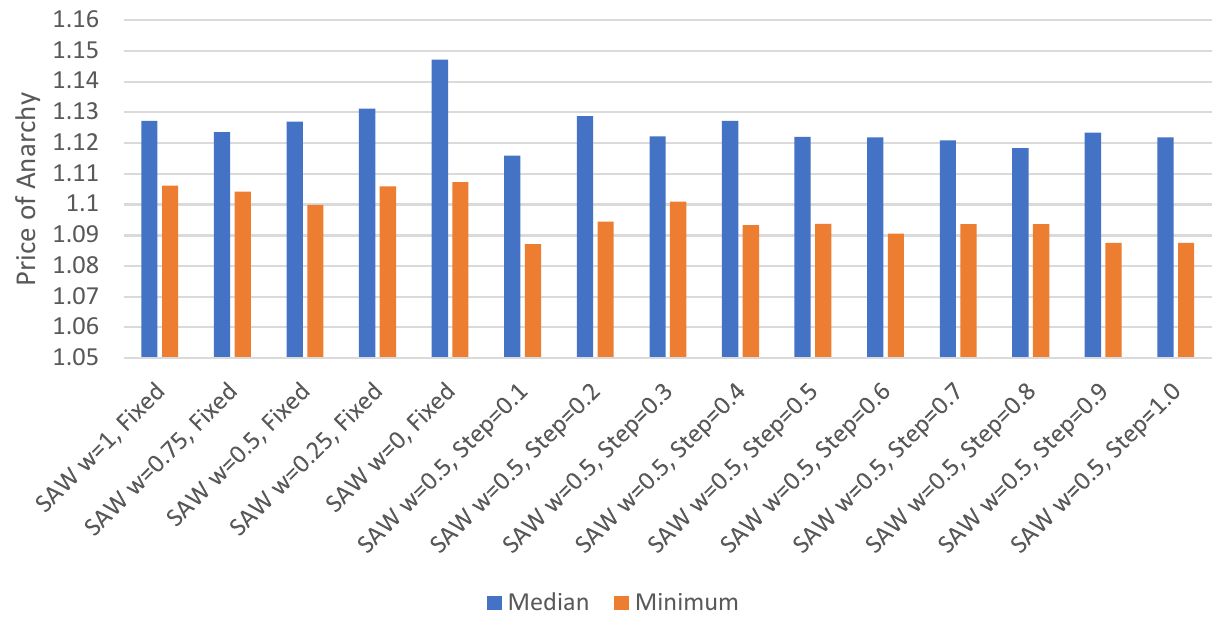
Figure 8. Minimum/Median Price of Anarchy with TIS,